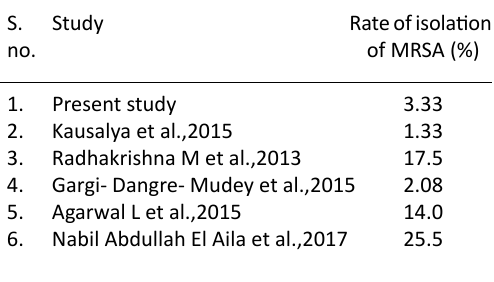
Table 7. Isolation rate of MRSA in different studies S.